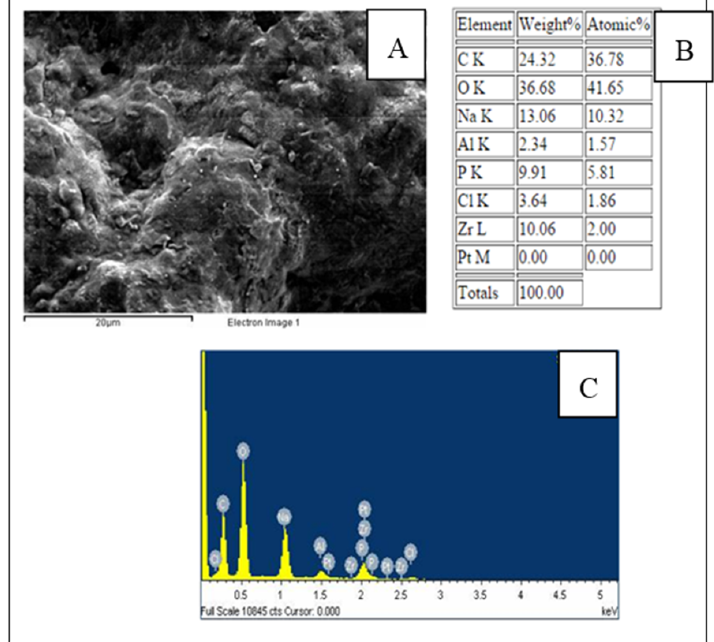
Figure 4. SEM photographs ( A ); EDX data; ( B ); and spectrum of SPCE/PEG-ZrO 2 /tyrosinase ( C ).